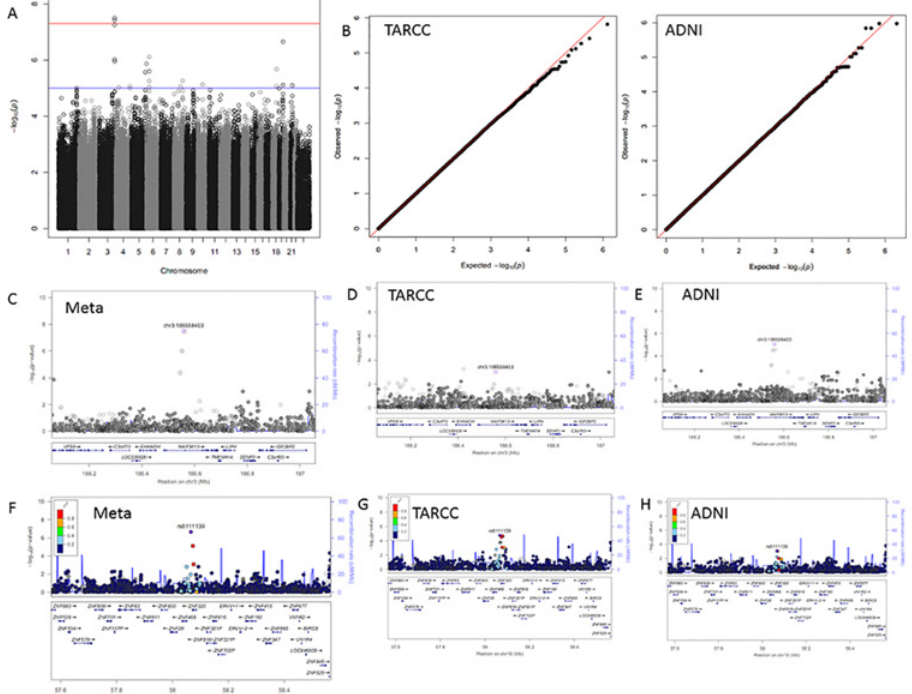
Fig 4. Adiponectin results. Panel A; GWAS Manhattan plot for meta-analysis of Adiponectin. Panel B; QQ plots for the association results for TARCC (left) and ADNI (right). Panel C; LocusZoom plot for the chromosome 3 signal from the meta-analysis. Panels D and E; LocusZoom plots for the chromosome 3 signal in TARCC and ADNI, respectively. Panel F; LocusZoom plot for the chromosome 19 signal from the meta-analysis. Panels G and H; LocusZoom plots for the chromosome 19 signal in TARCC and ADNI, respectively.